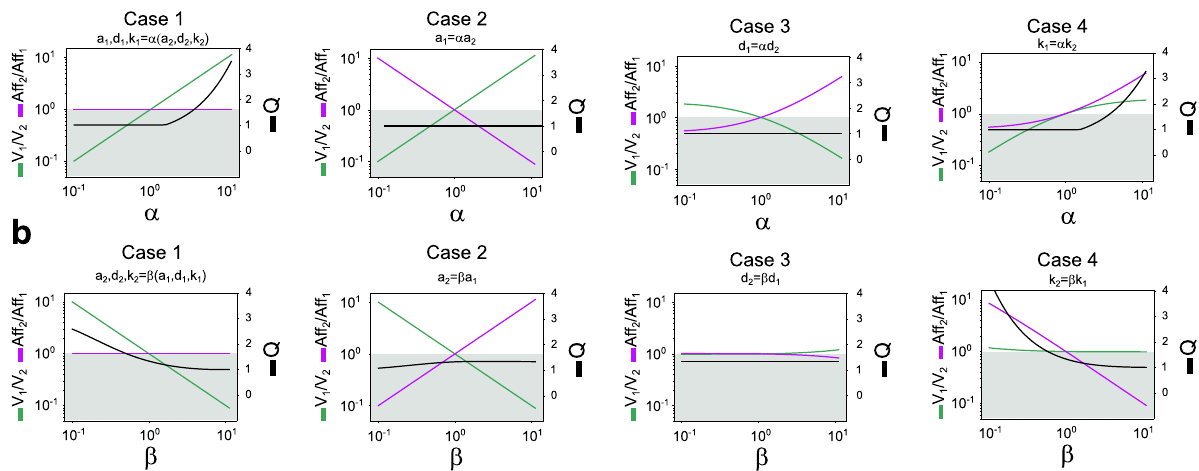
Fig. 2 Signal termination in a CMC: kinase faster than phosphatase, phosphatase with higher af fi nity. a Velocity of the kinase ( E 1 ) relative to that of the phosphatase ( E 2 ) and af fi nity of the phosphatase relative to that of the kinase (phosphatase parameters values as in Fig. 1b). In each plot, V 1 / V 2 and Aff 2 / Aff 1 are indicated in the left axis while Q ( = P max / P ss ) is indicated in the right axis. V 1 / V 2 is plotted in green, Aff 2 / Aff 1 in purple, and Q in black. The shadowed region over the plot indicates values of Q < 1.6 (no signal termination). b Velocity and af fi nity of the phosphatase relative to those of the kinase (kinase parameters as in Fig. 1b). Other details are as in a . Parameter values: a 1 = 3.5; d 1 = 1; k 1 = 50; a 2 = 0.3; d 2 = 0.25; k 2 = 0.25; E 1T = 100; E 2T = 100; S T =